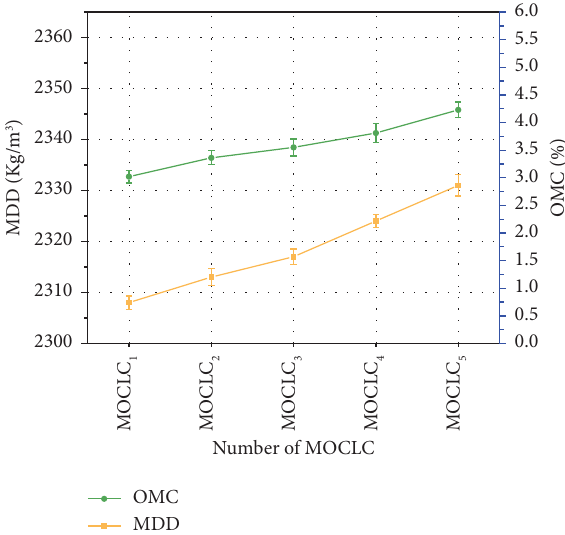
Figure 1: Efect of cement content on fresh properties of MOCLC.